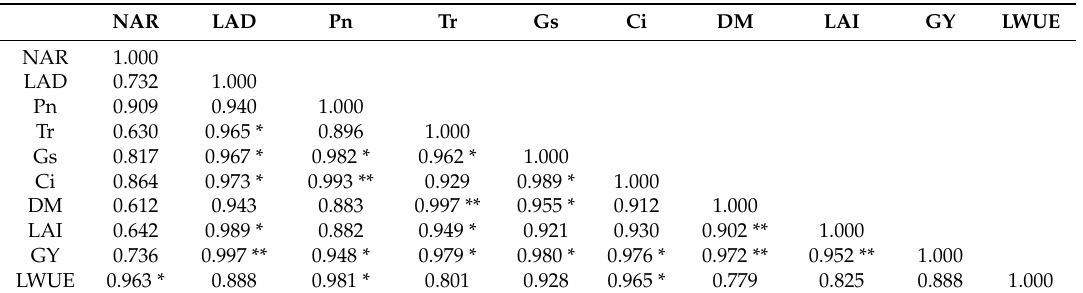
Table 7. Pearson correlation coefficients and associated significance level for final grain yield between selected corn canopy parameters as influenced by subsoil tillage